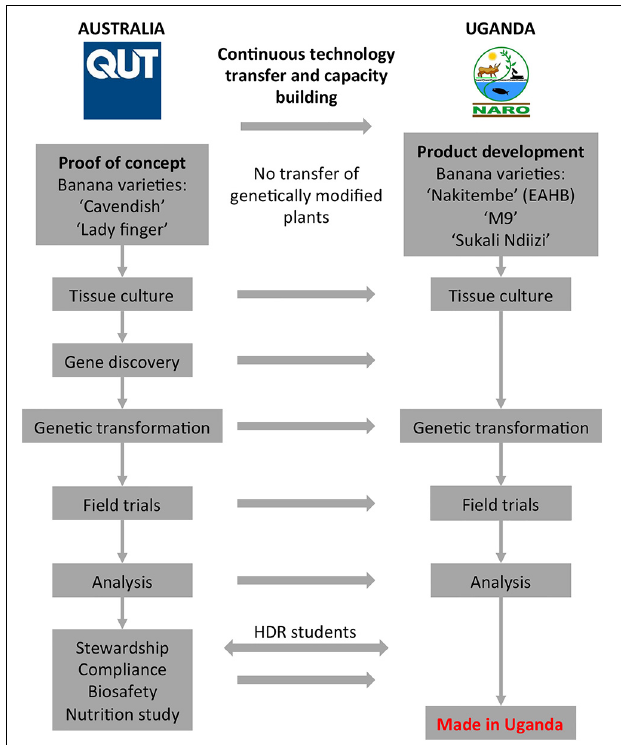
FIGURE 1 | The Banana21 project. EAHB, East African highland banana, HDR, higher degree